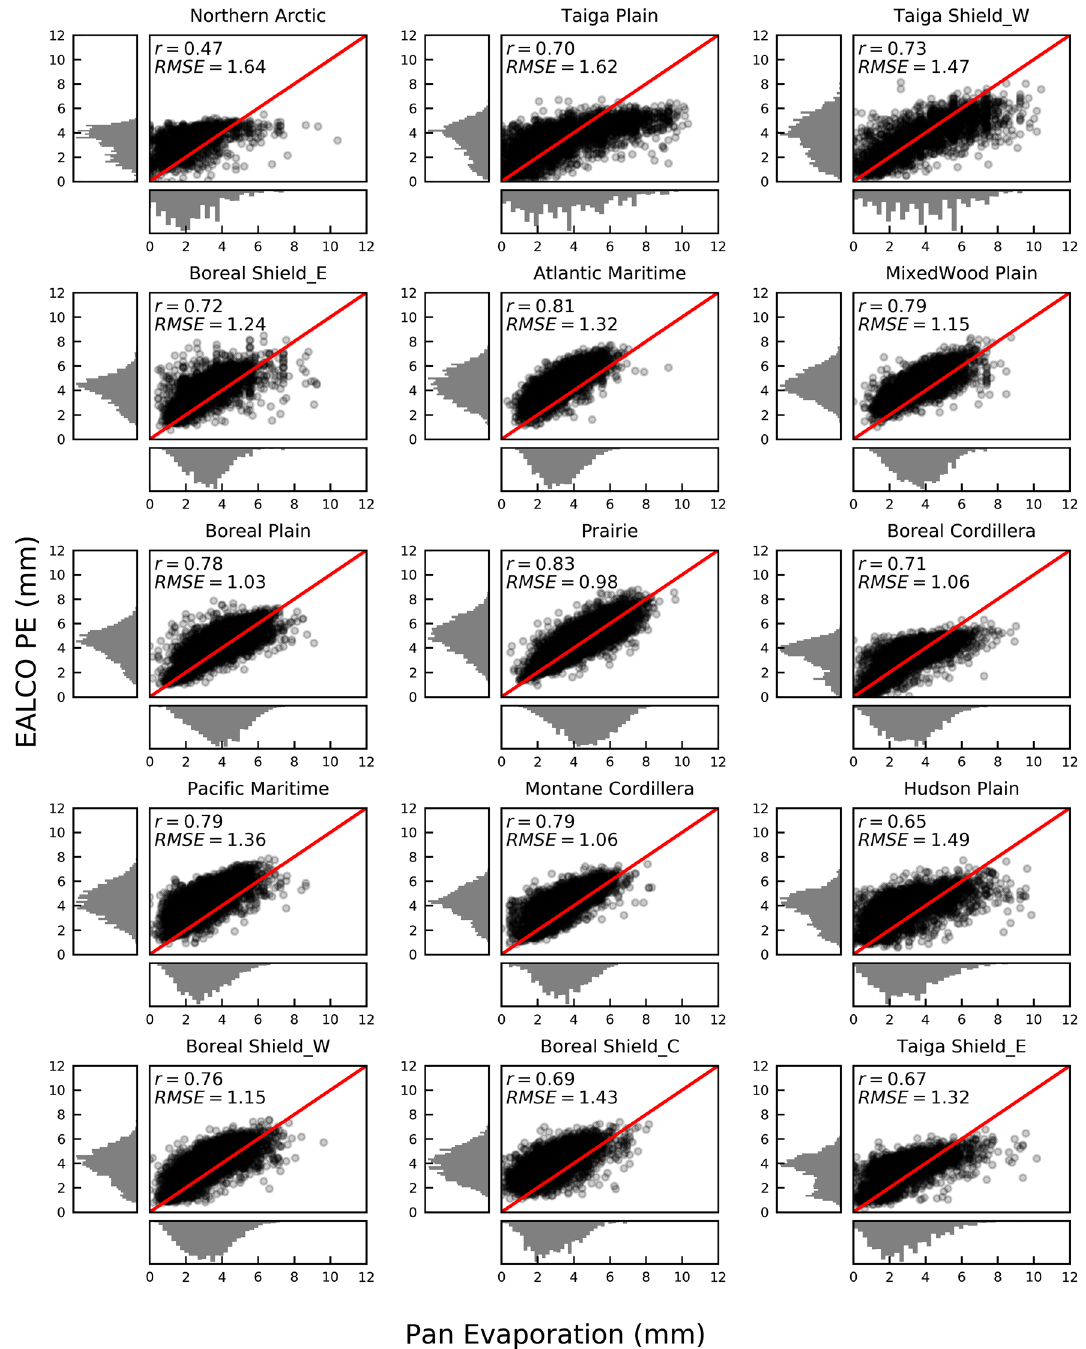
Figure 2. The scatterplots and the histograms of daily EALCO PE (mm) and Pan evaporation (E pan , mm) with the correlation coefficient (r), Root Mean Squared Error (RMSE), and 1:1 line in red in May (or June in Northern Arctic) to September 1979–2007 in 15 ecozones of